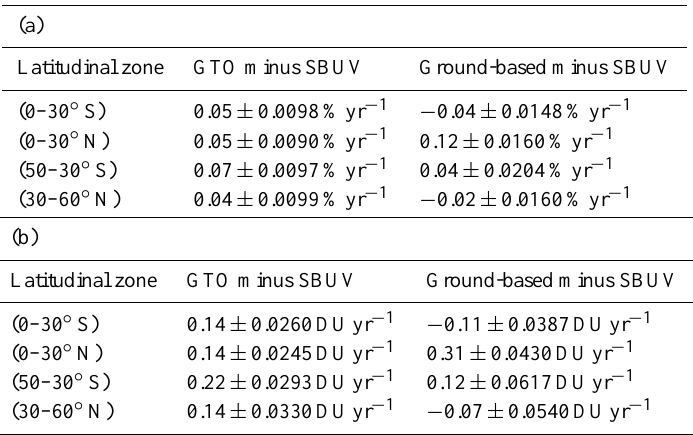
The entries in brackets represent the reduction compared to analysis based on monthly zonal mean anomalies. Table 8. (a) Trend of the differences (in % per year) for monthly zonal mean total ozone and (b) trend of the differences (in DU per year) for monthly zonal mean total